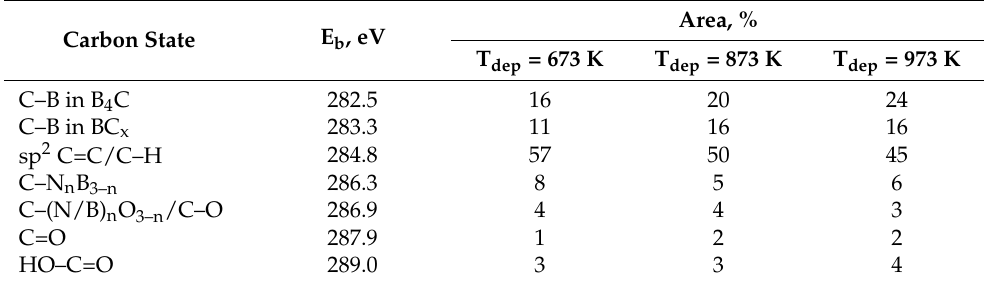
Table 4. Fine structure of C1s spectra of the LPCVD BC x N y films deposited at different temperatures.